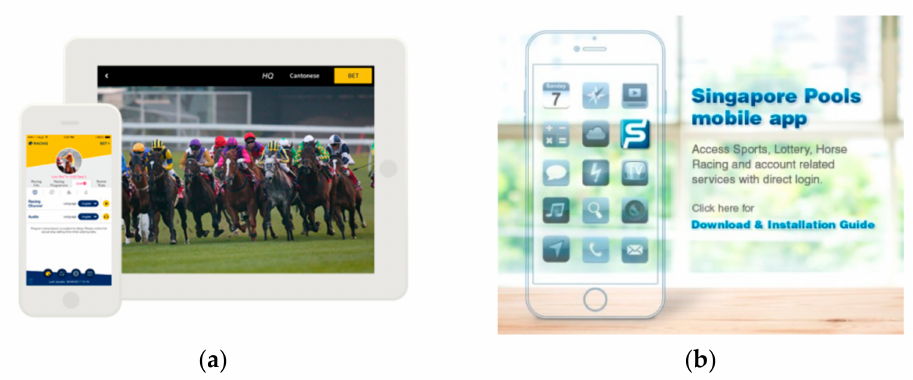
Figure 1. Mobile betting app from ( a ) Hong Kong [19] and ( b ) Singapore